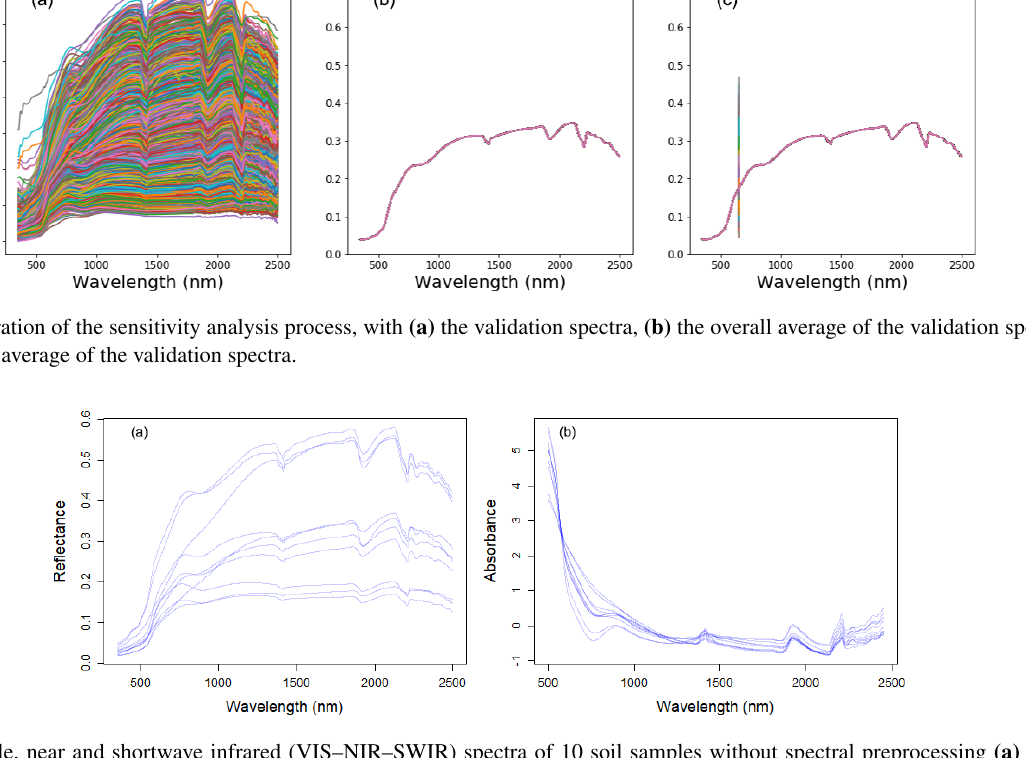
Figure 4. Visible, near and shortwave infrared (VIS–NIR–SWIR) spectra of 10 soil samples without spectral preprocessing (a) and with spectral preprocessing (b)